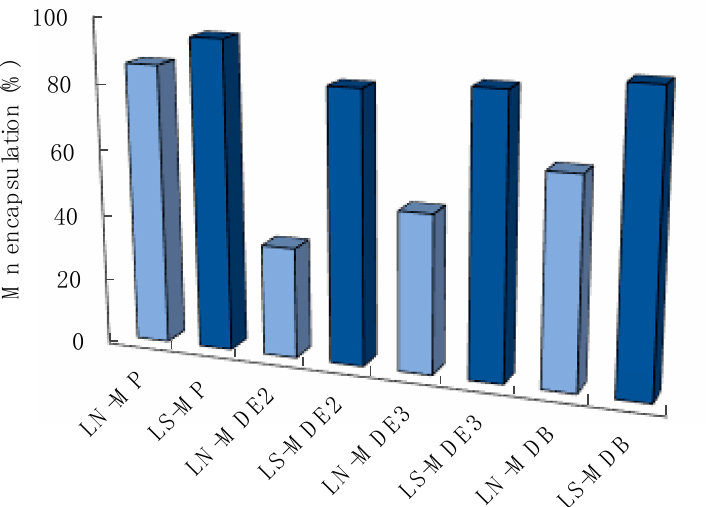
Figure 6. Manganese complexes encapsulated in the lipid phase of LN (light blue) and LS (blue) after ultracentrifugation, expressed as a percentage with respect to total amount of manganese used in the formulation.